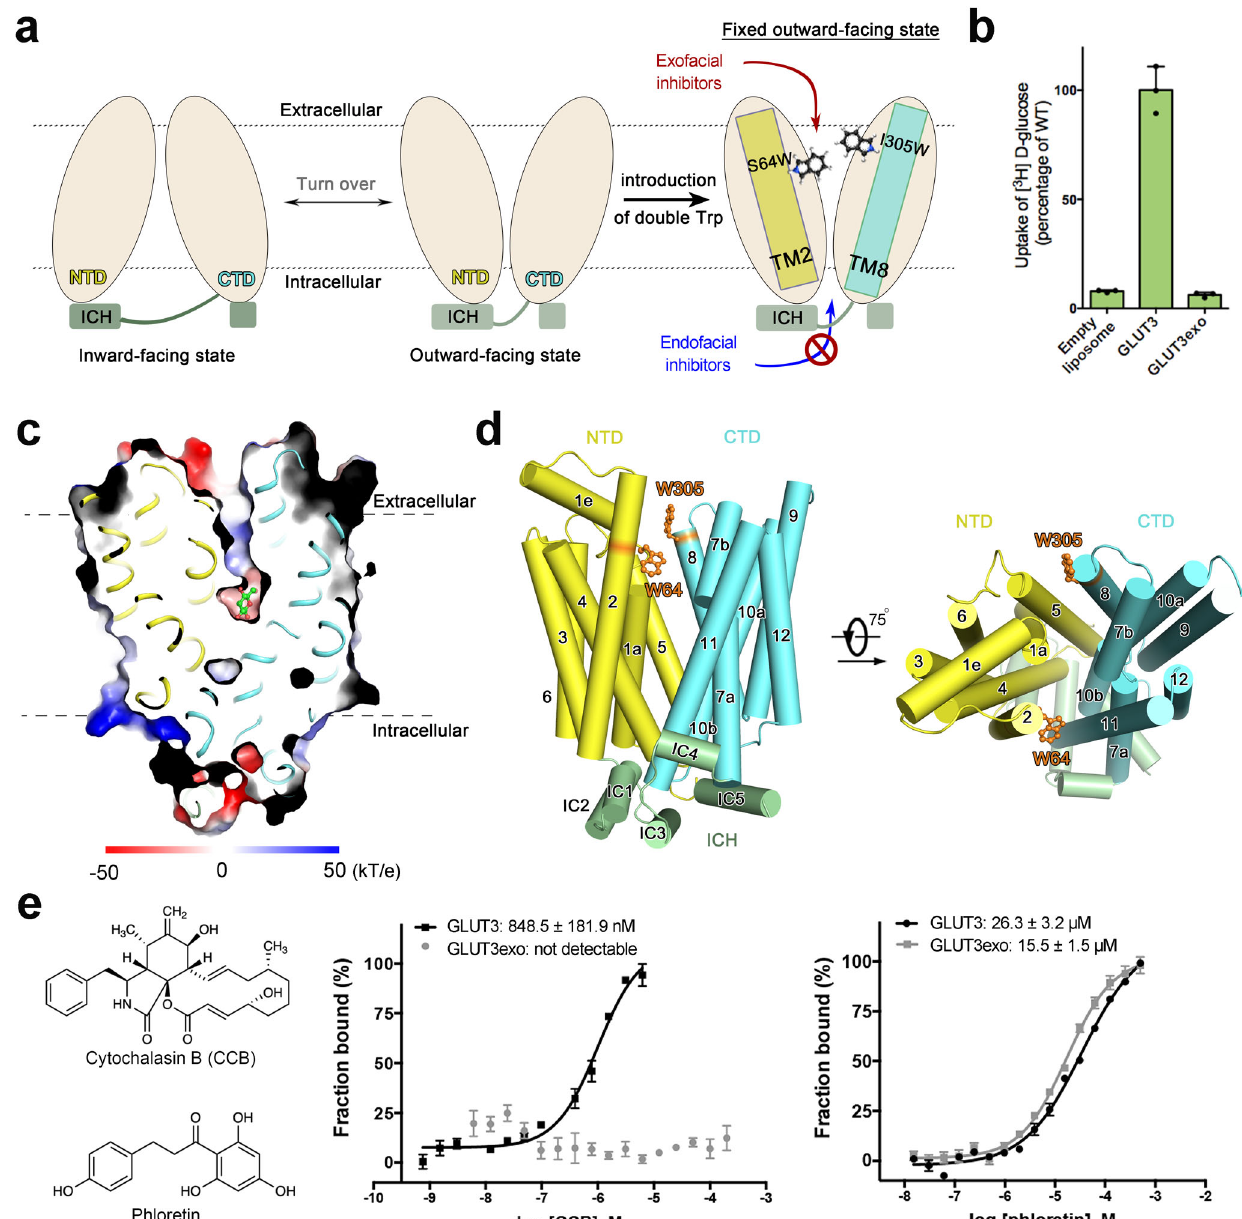
Fig. 1 GLUT3 containing a double point mutation is trapped in an outward-facing state. a Structure-guided design of a constitutively outward-facing GLUT3 variant. Wild-type (WT) GLUT3 alternates between the inward-facing (left) and the outward-facing (middle) states during a transport cycle. Introduction of a double Trp mutation, S64W and I305W, designated GLUT3exo, may lock the transporter in a constitutively outward-facing state that can only bind to exofacial inhibitors. NTD amino-terminal domain, CTD carboxy-terminal domain, ICH intracellular helical domain, TM transmembrane segment. b GLUT3exo loses transport activity. The activities of GLUT3 variants were examined in the proteoliposome-based counter fl ow assay. Empty liposome refers to protein-free control. The transport activity of GLUT3exo was normalized against that of WT GLUT3. Data represent mean ± SD of three independent experiments. c Crystal structure of GLUT3exo displays an outward-facing state. Shown here is a cut-open side view of the electrostatic surface potential of GLUT3exo. Glucose is shown as green ball and sticks. d Overall structure of the outward-facing GLUT3exo. The introduced Trp residues are shown as orange ball and sticks. GLUT3exo is domain colored with yellow, cyan, and pale green for the N-terminal, C-terminal, and ICH domains, respectively. e GLUT3exo selectively binds to the exofacial inhibitor phloretin, but not the endofacial cytochalasin B (CCB). Left : Chemical structures of CCB and phloretin. Middle and Right : Microscale thermophoresis (MST) measurement of the af fi nities of WT GLUT3 and GLUT3exo with the endofacial inhibitor CCB (middle) and the exofacial inhibitor phloretin (right). Data represent mean ± SEM of three independent measurements. Source data are provided as a Source Data fi